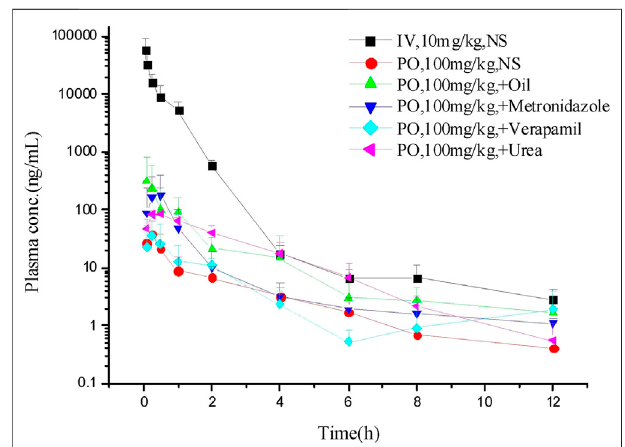
Frontiers in Pharmacology |